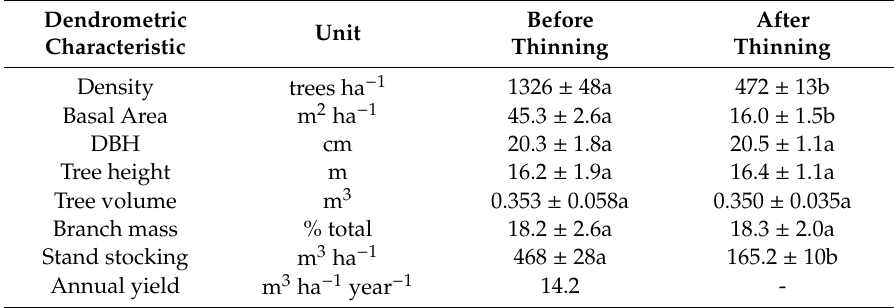
Table 1. Dendrometric characterization of the stand studied, average results obtained from 16 sampling plots (average ± standard deviation). Di ff erent letters indicate significant di ff erences between averages by t test with p -value <